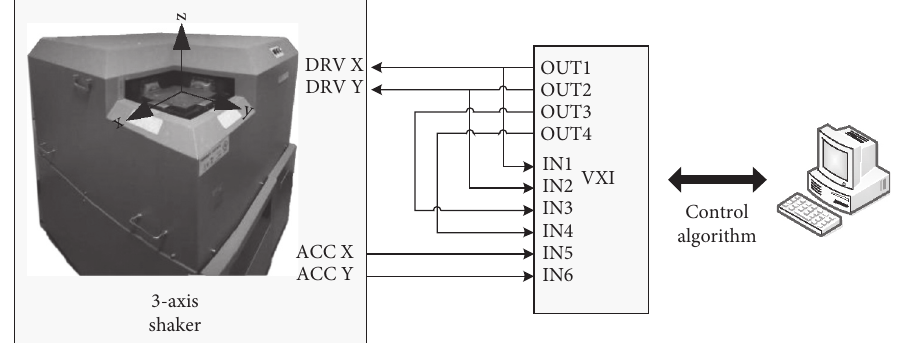
Figure 9: Test system constitution.